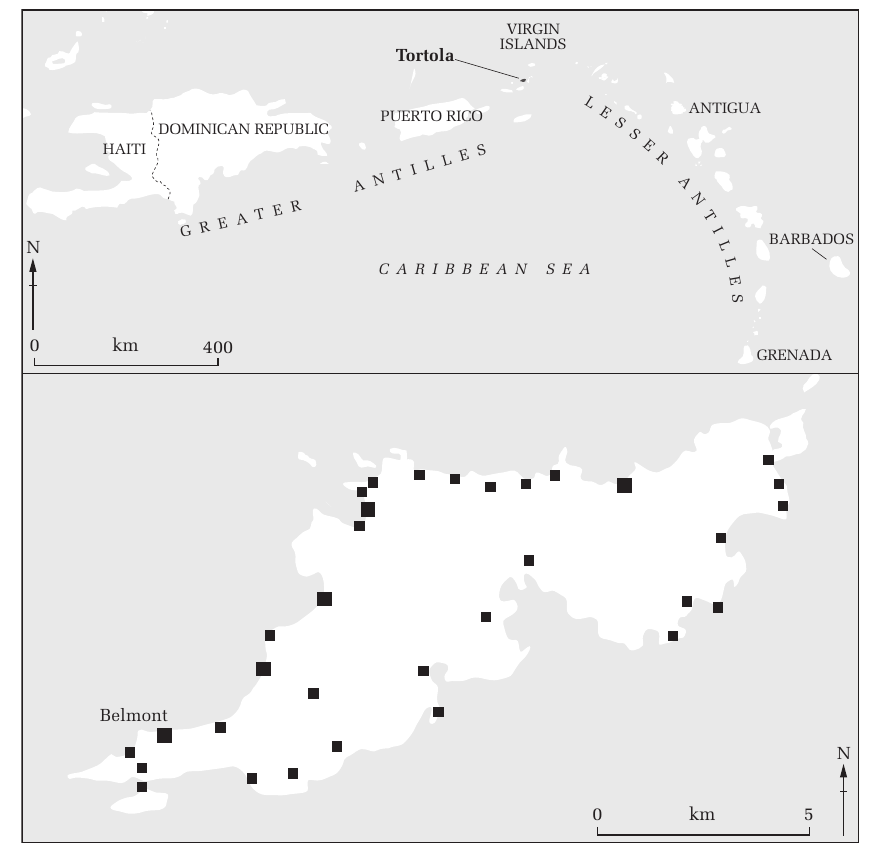
Figure 1 The location of Tortola in the eastern Caribbean and (below) the distribution of known prehistoric settlement sites on the island; large squares represent major